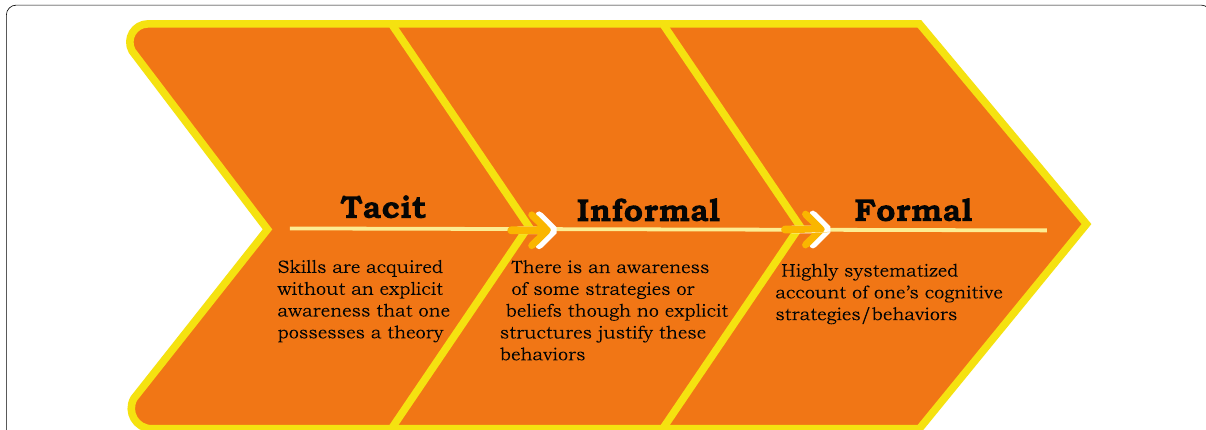
Fig. 1 Schraw and Moshman model. According to Schraw and Moshman, metacognitive skillfulness is on a continuum. The three levels identified are separated by one’s level of awareness and